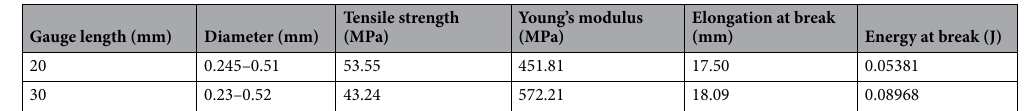
Table 2. Summary of tensile characteristics of CTF single fibers.